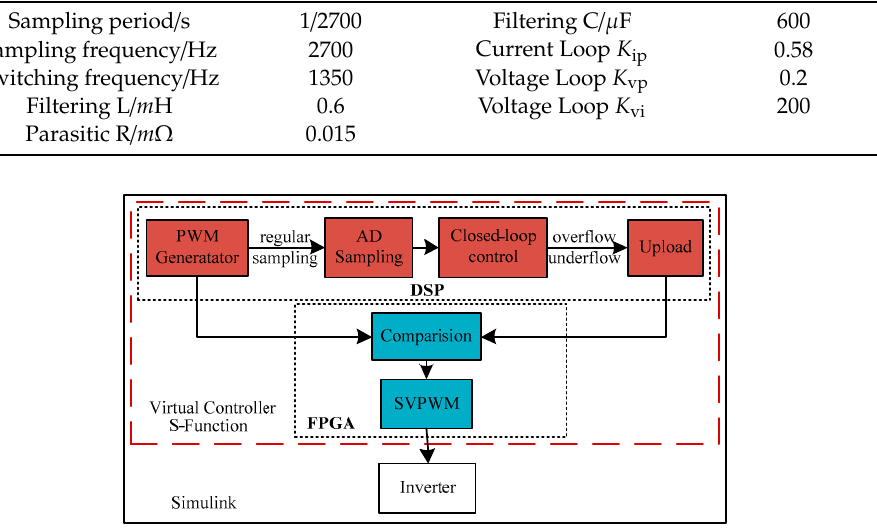
Figure 13. Simulation waveform with instantaneous unbalanced load.